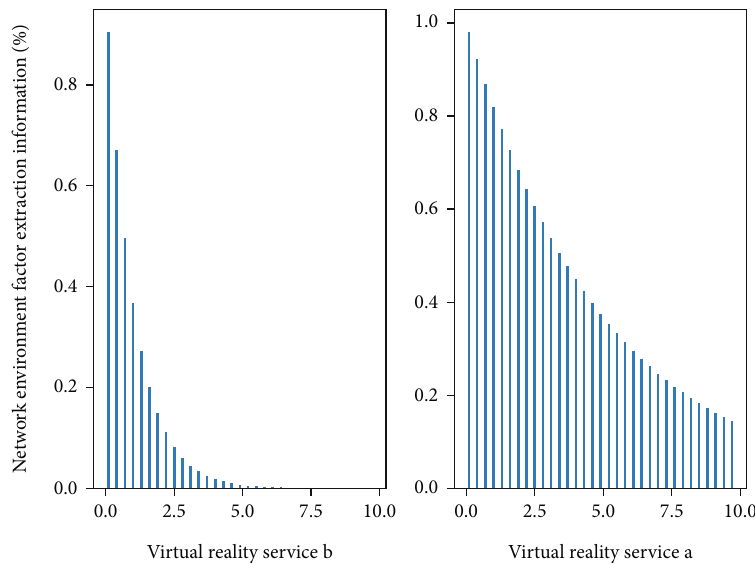
Figure 4: Extraction of virtual reality network environment